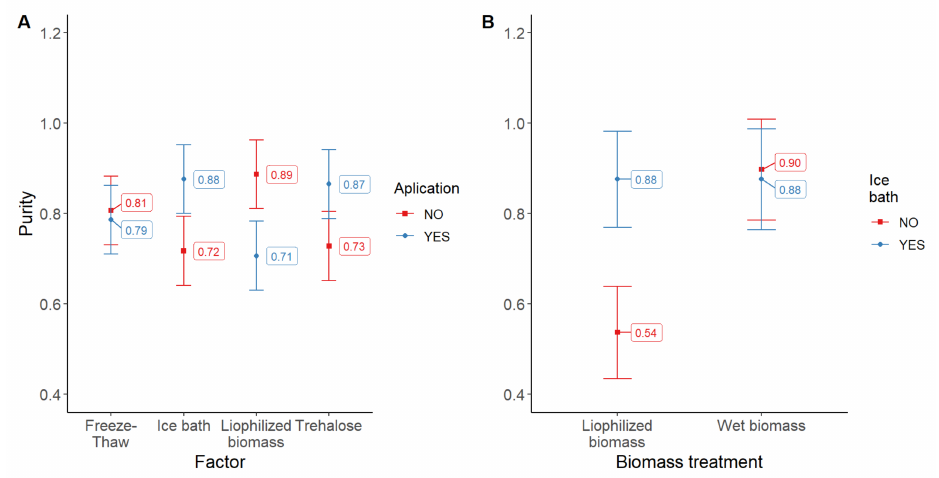
Figure 8. Comparative purities of phycocyanin ( A ) as a function of three operational factors and trehalose as osmoprotectant; and ( B ) as a function of the interaction between biomass treatment versus ice-water bath application. Bars show the least significant difference intervals for 95%